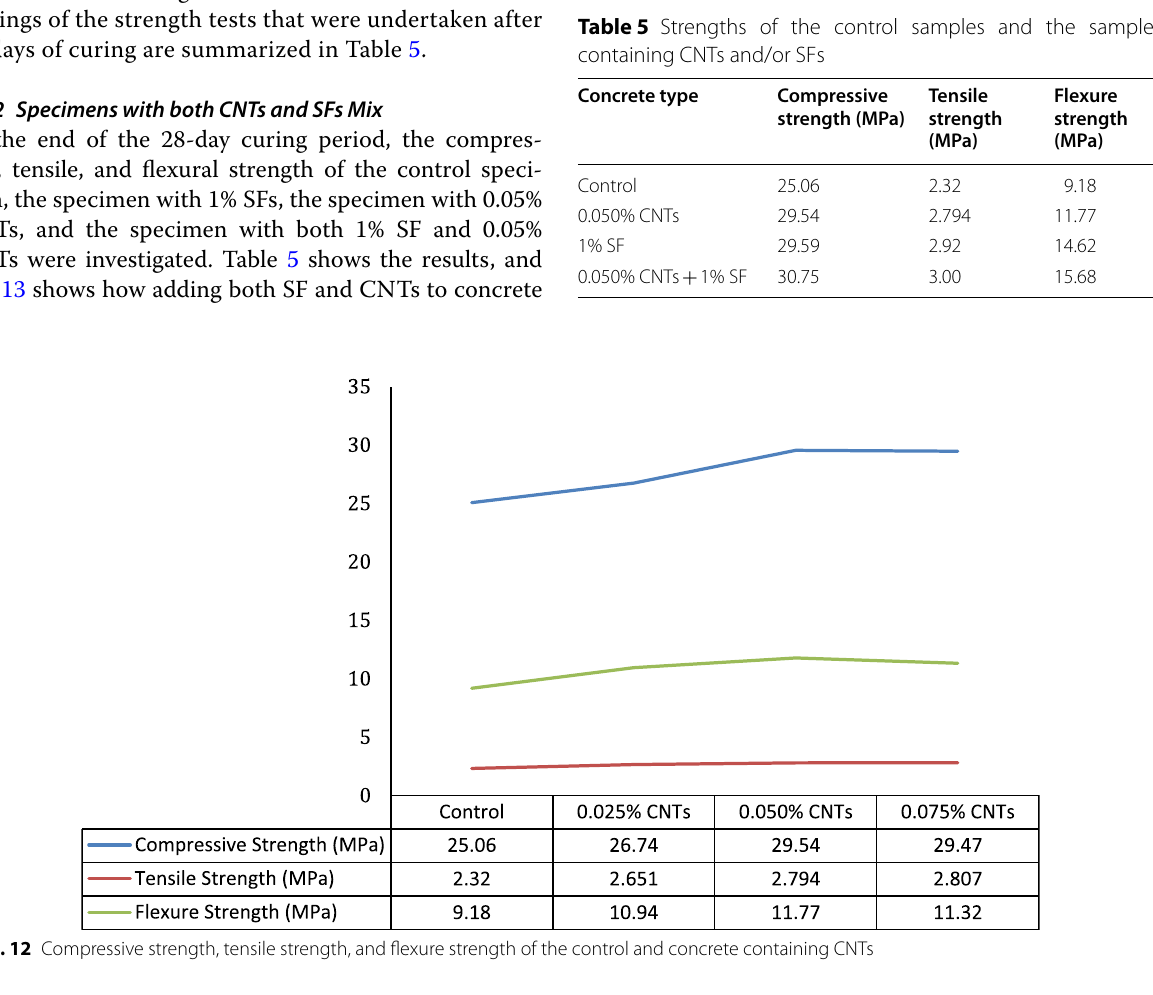
Table 4 and Fig. 12 show the compressive strength, ten- sile strength, and flexure strength data obtained after 28 days.